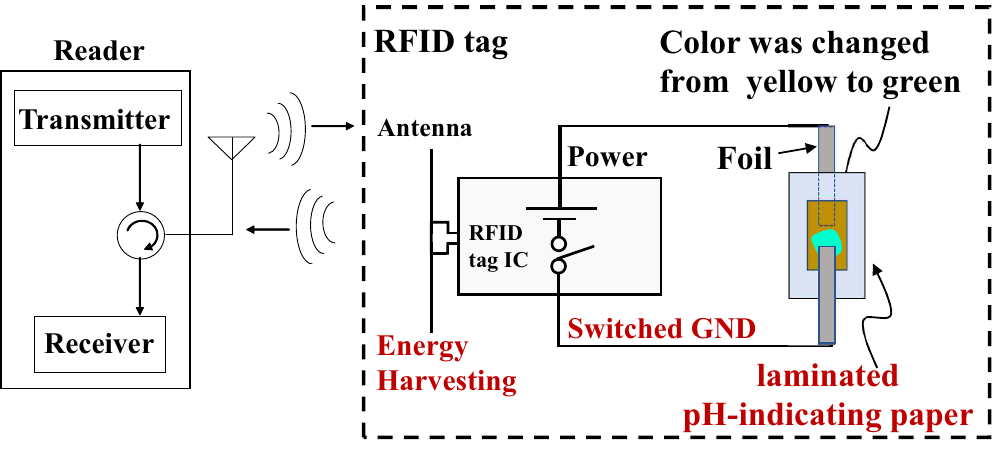
Figure 4. Framework of color-change RFID tag.